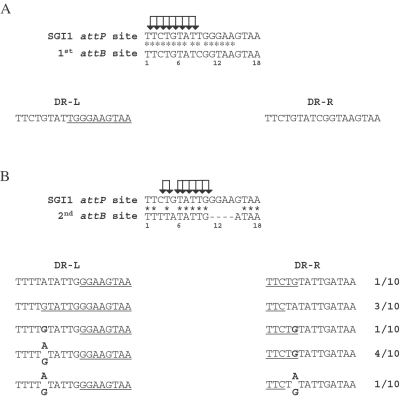
Comparison of the SGI1 18 bp attP, attB, DR-Ls, DR-Rs of S. Typhimurium.(A) Alignment of the attP site of SGI1 and the primary attB site (1st
attB) of S. Typhimurium strain LT2. The sequence of direct repeats left (DR-L) and right (DR-R) flanking integrated SGI1 were indicated. (B) Alignment of the attP site of SGI1 and the secondary attB site (2nd
attB) of S. Typhimurium strain LT2. The sequence of direct repeats left (DR-L) and right (DR-R) were determined in ten independent ΔthdF mutant S. Typhimurium LT2 SGI1 transconjugants from three mating experiments. (*) indicated identical positions in the attP site and the attB sites. Positions 1, 6, 12, and 18 are indicated below the 1st and 2nd
attB sequences. The specific nucleotides for attP are underlined in DR-Ls and DR-Rs. Sites of possible cleavage during the strand exchange are indicated by arrows in attP. Nucleotides in boldface letters represent illegitimate base pair in the DR-L and DR-R sequences. The sequences of DR-L and DR-R of some transconjugants revealed a mix of G and A at position 5 in repeated attempts.